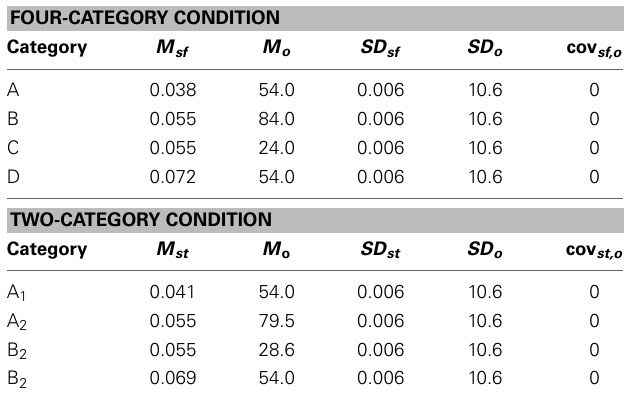
Table 2 | Category distribution parameter values for Experiment